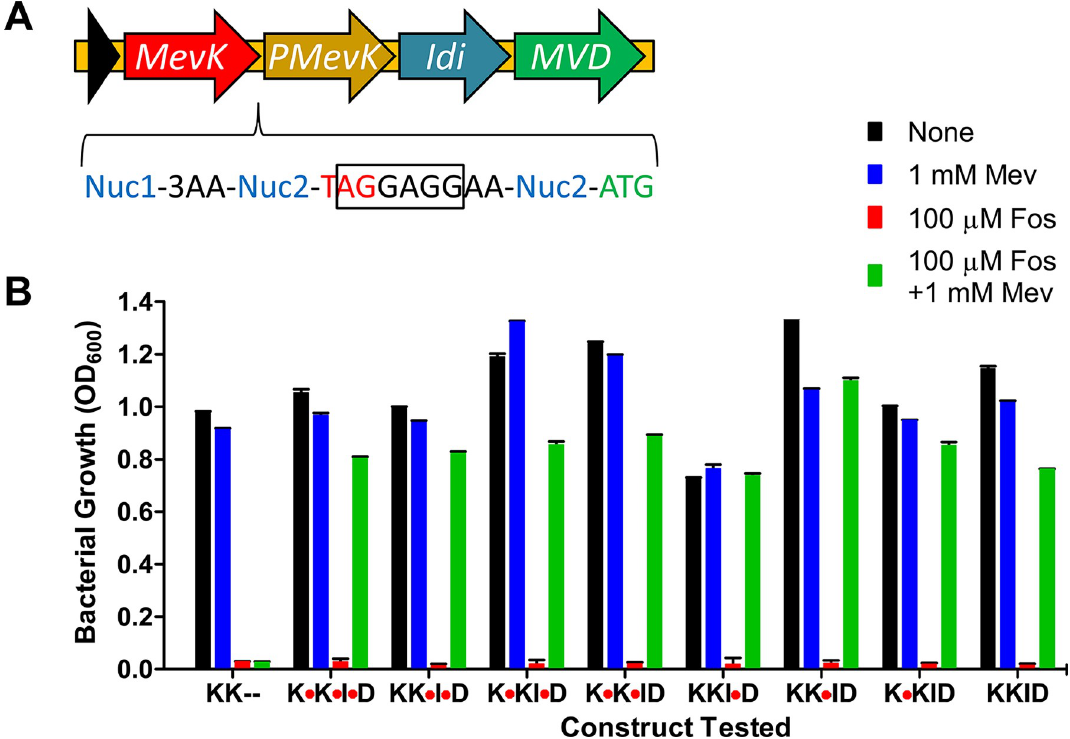
Fig 1. Design and validation of a multi-protein expression system for mevalonate pathway genes. A) Streptococcus pneumoniae mevalonate kinase ( mevK ), Homo sapiens phosphomevalonate kinase ( pmevK ), E . coli isopentenyl diphosphate isomerase ( idi ), and S . pneumoniae mevalonate 5-diphosphate decarboxylase ( mvd ) were arranged for polycistronic expression in E . coli with a stop codon (red) and ribosomal binding site (black box) between each pair of genes. Digestion with a specific endonuclease (Nuc2) allowed these elements to be removed for expression of a multi-functional proteins linked by flexible three amino acid linkers (3AA). B) The eight possible ways of connecting the four genes (red octagons show retention of the stop codon) were tested by attempting to rescue the growth of E . coli inhibited with the isoprenoid synthesis inhibitor fosmidomycin (Fos). Successful growth in the presence of mevalonate (Mev) showed that all eight constructs rescued fosmidomycin inhibition in a mevalonate-dependent manner, while the negative control only containing the two kinases (KK—) did